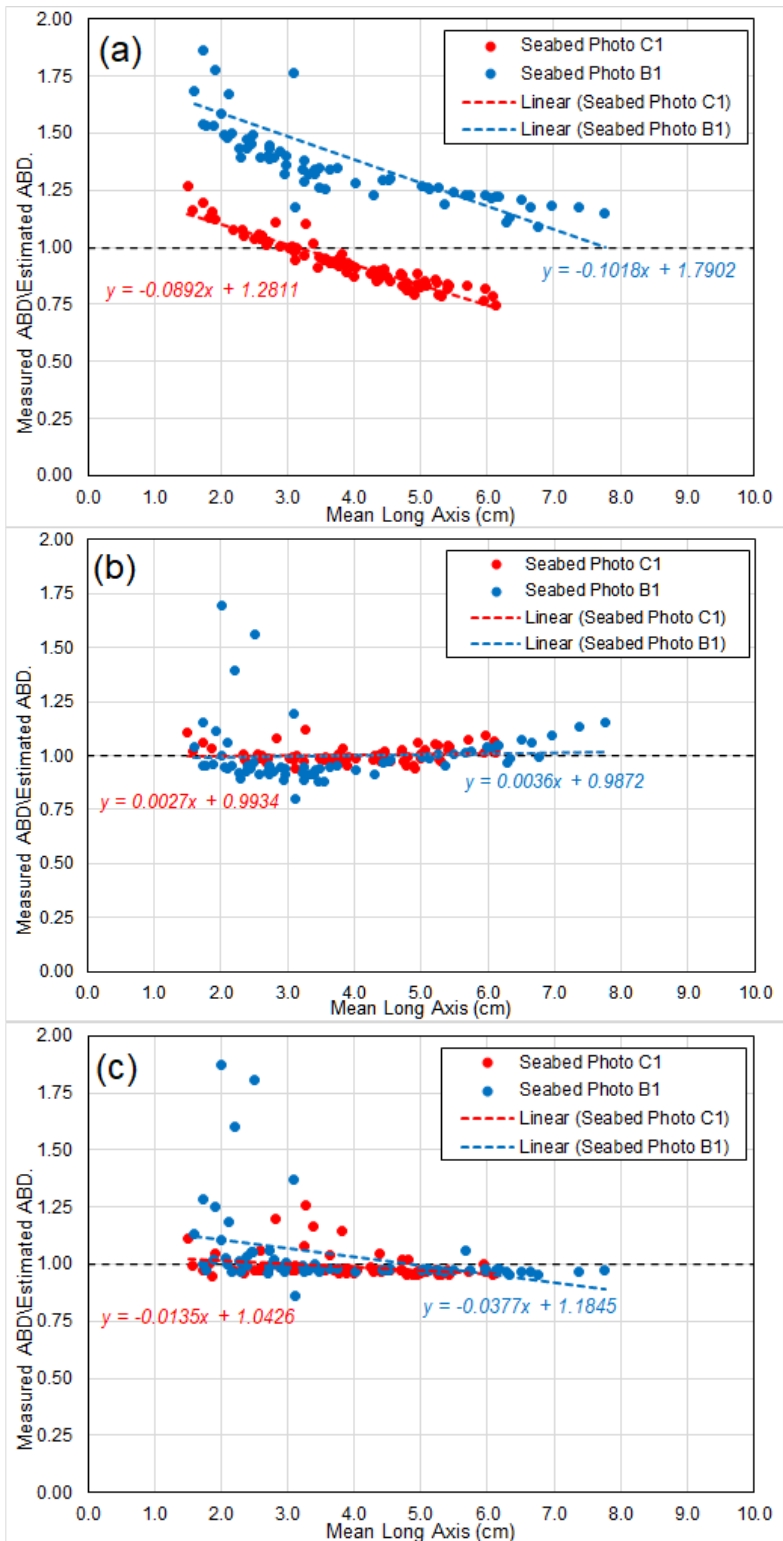
Figure 12. Comparisons of the measured Abundances and the predicted ones by the new empirical method with Dataset 3: ( a ) by empirical formula Equation (19); ( b ) by empirical formula Equation (19) with a linear adjustment; ( c ) by empirical formula Equation (25). Estimates of coverage using the new empirical method show mixed but encouraging results when compared with field measurements from three areas (Figure 13). Dataset 2